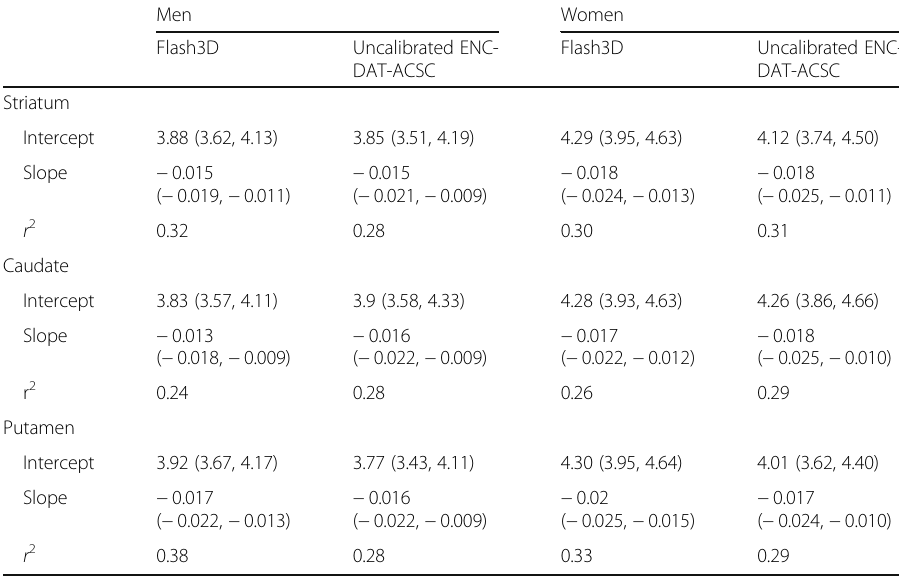
Table 7 Comparison of linear regression parameters from the generated Flash3D database with those from the ENC-DAT study using BRASS analysis of uncalibrated and ACSC